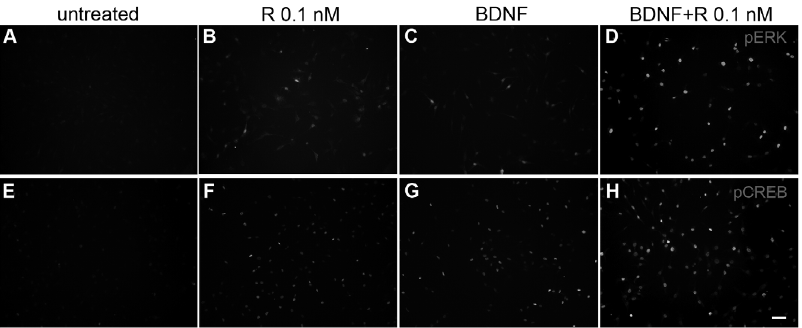
Figure 2. Rolipram and BDNF application induced the activation of ERK and CREB. Immunofluorescence staining of activated ERK (pERK; A–D) and activated CREB (pCREB; E–H) in spiral ganglion cell cultures incubated in medium for 48 h (A, E) or exposed to Rolipram (R; B, F) or BDNF (C, G) for 30 min after a pre-incubation of (47 h, 30 min) in medium. D, H shows the pERK and pCREB immunoreactivity in cells pre-treated with BDNF (47 h, 30 min) and additionally exposed to Rolipram for 30 min (D, H). Photographs were taken under the same conditions in which exposure time and intensity was adjusted to the untreated control group (A, E). Application of Rolipram (B, F) or BDNF (C, G) induced the activation of ERK and CREB. Stronger pERK and pCREB immunoreactivity was observed after co-treatment with Rolipram and BDNF (D, H). BDNF: brain-derived neurotrophic factor; R: Rolipram. Scale bar: 50 m m (A–H).